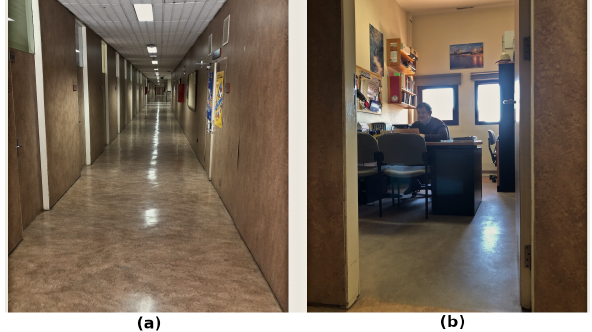
Figure 18. Real scenario for testing the proposed method: ( a ) corridor, ( b )